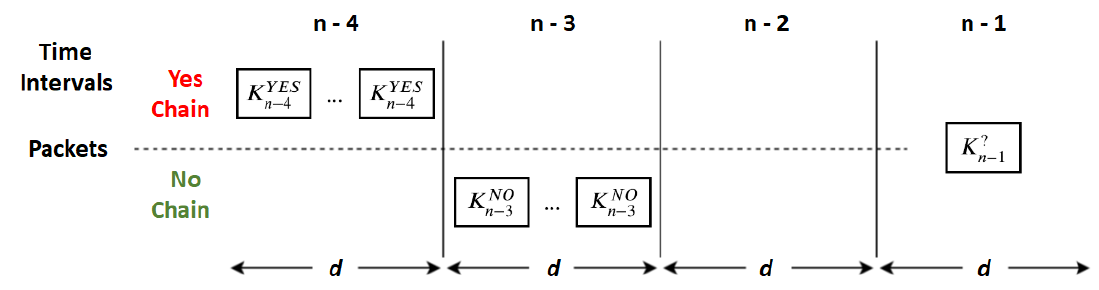
) given a past of 1 n −